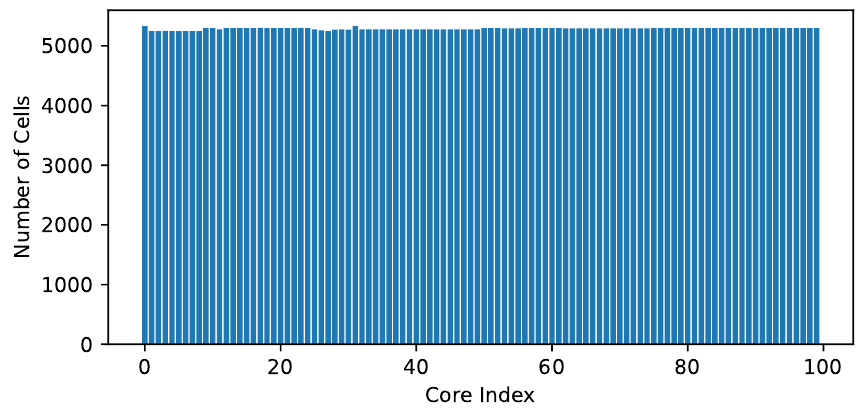
Figure 29. Distribution of cells in the mesh partitioning given in Figure